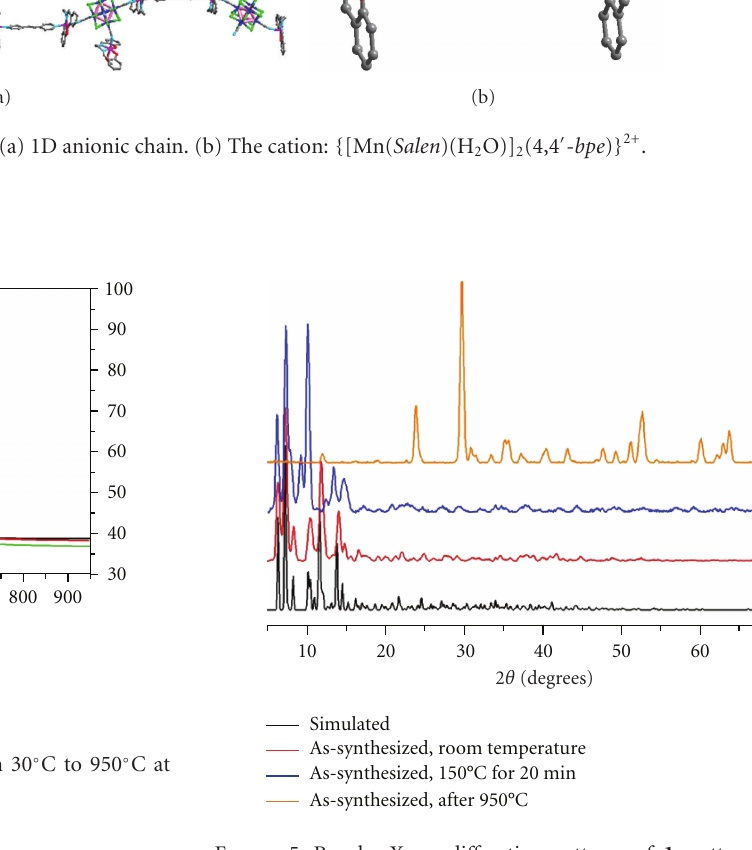
Figure 5: Powder X-ray di ff raction patterns of 1 : pattern simu- lated from crystal structure in black; observed pattern at room temperature in red; observed pattern after being heated at 150 ◦ C for 20 minutes in blue; observed pattern after being heated to 950 ◦ C in orange which corresponds to a mixture of MnNb 2 O 6 and Mn 3 O 4